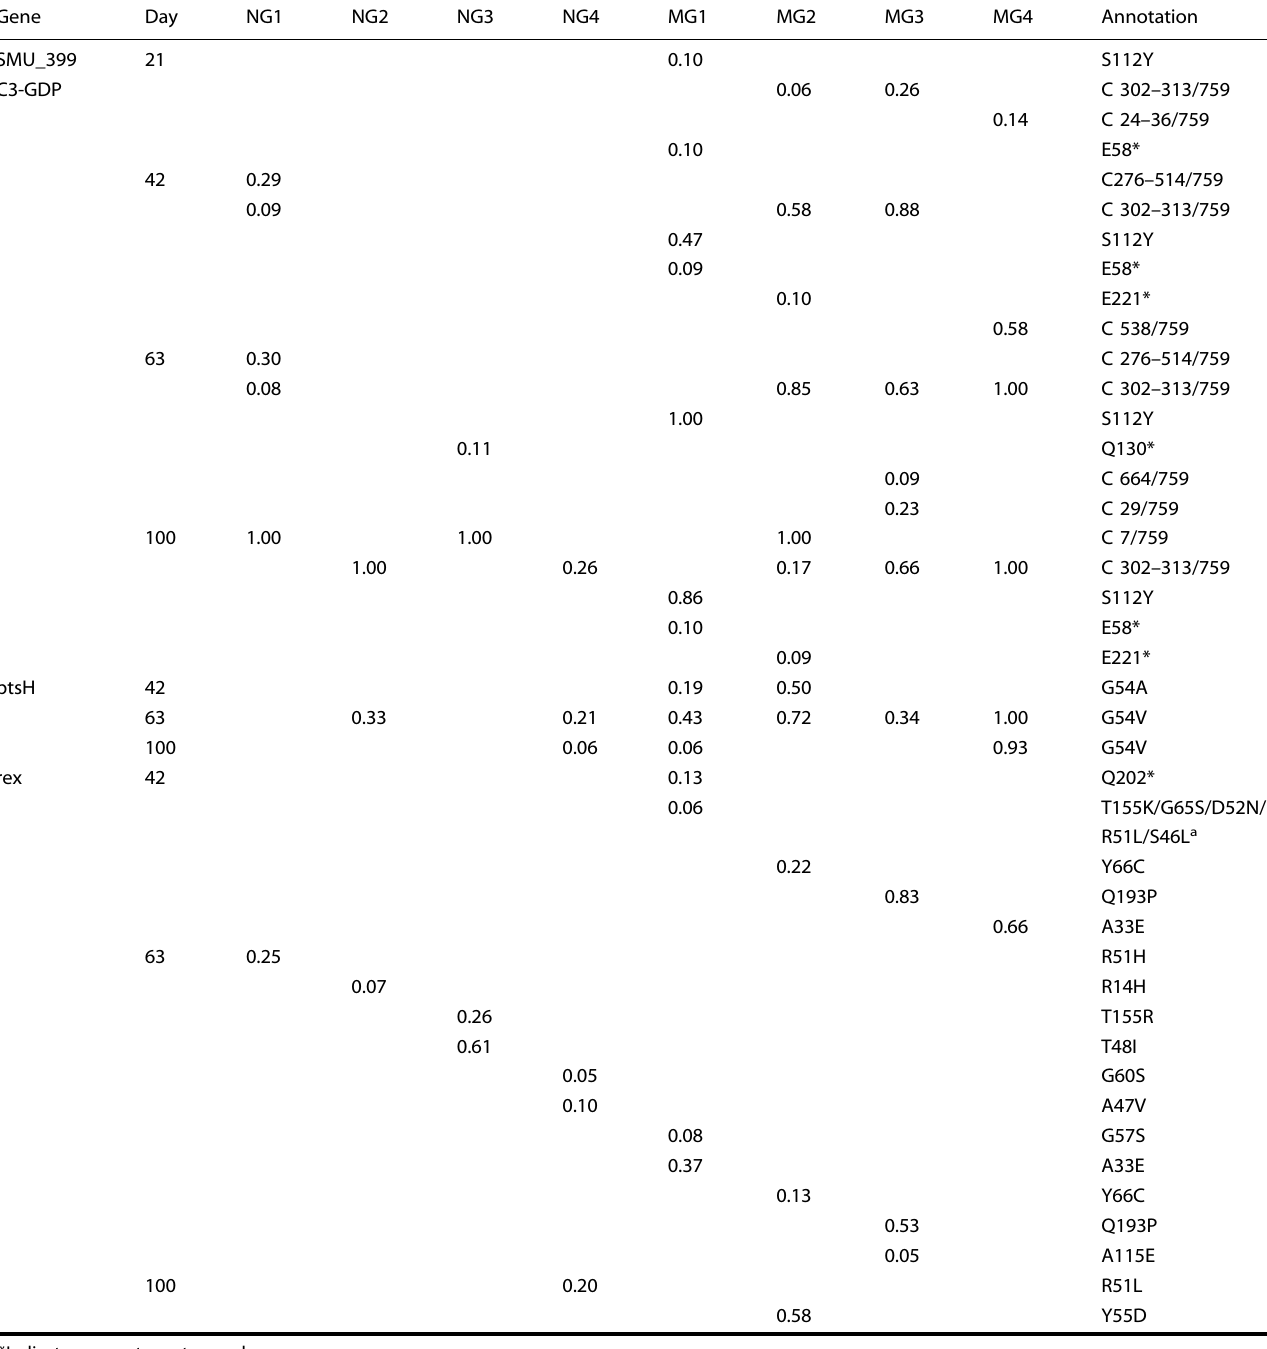
Table 1. Frequency of mutations detected earlier in simulated microgravity populations.